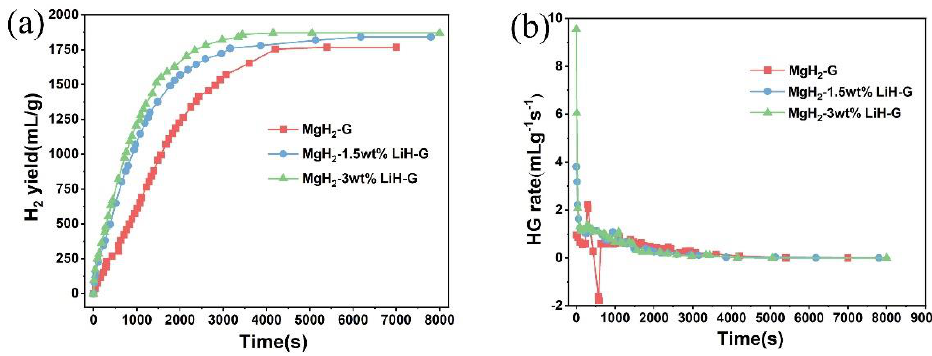
Figure 4. ( a ) Hydrogen generation curves and ( b ) hydrogen generation rate of MgH 2 -G, MgH 2 -1.5 wt % LiH-G, and MgH 2 -3 wt % LiH-G.